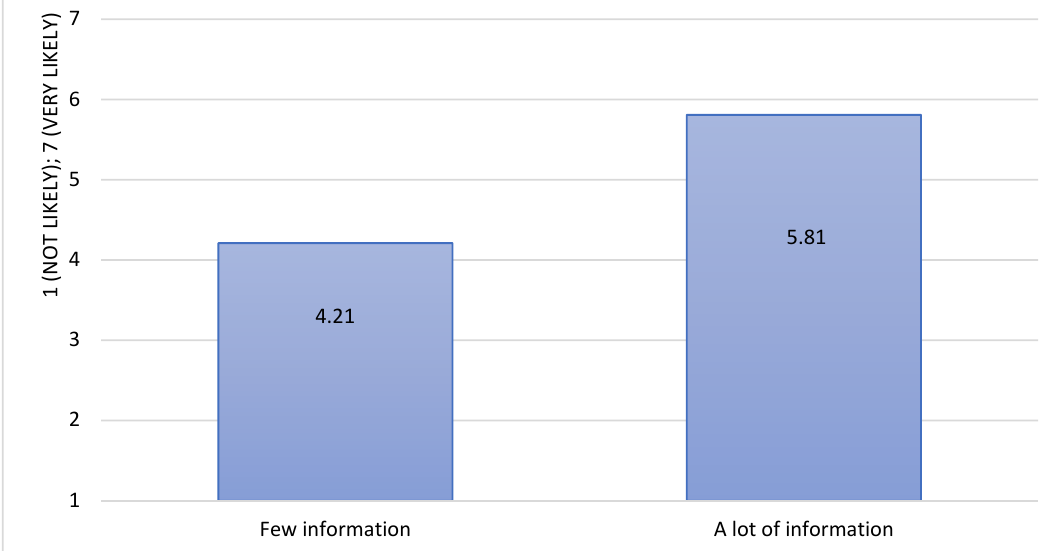
Figure 13. Probability of adopting agroecological practices in the future depending on the degree of information regarding the agrochemicals.